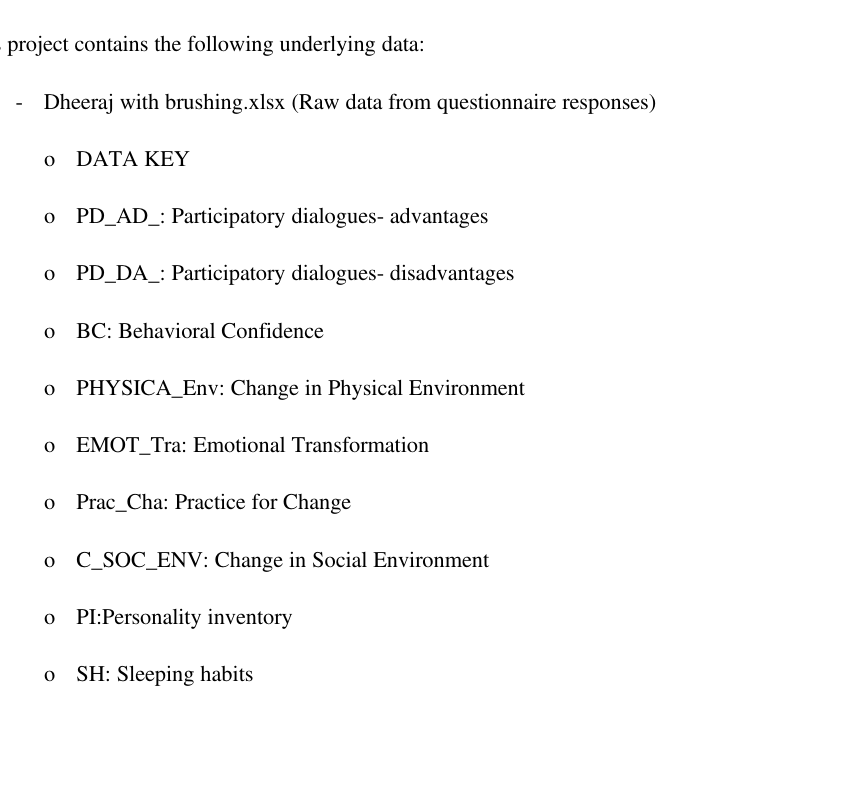
Figshare: Novel behavioral model in evaluating initiation and sustenance of brushing behavior among students pursuing health sciences. https://doi.org/10.6084/m9.figshare.17209718 31 This project contains the following underlying